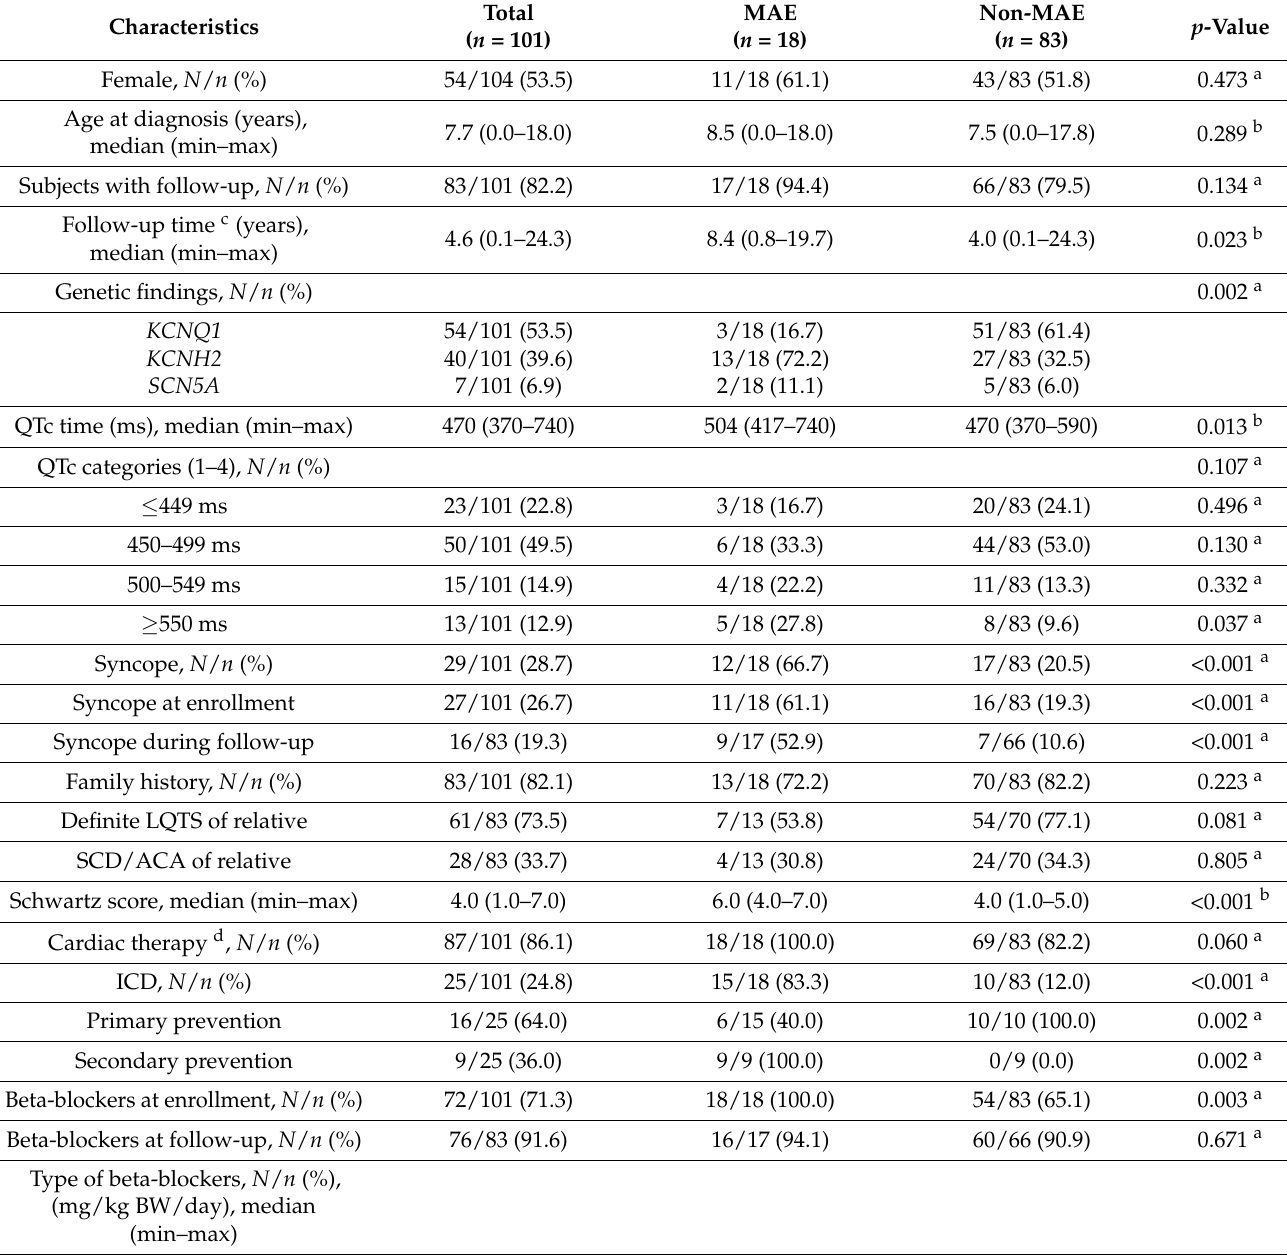
Table 2. Characteristics with clinical and genetic findings by